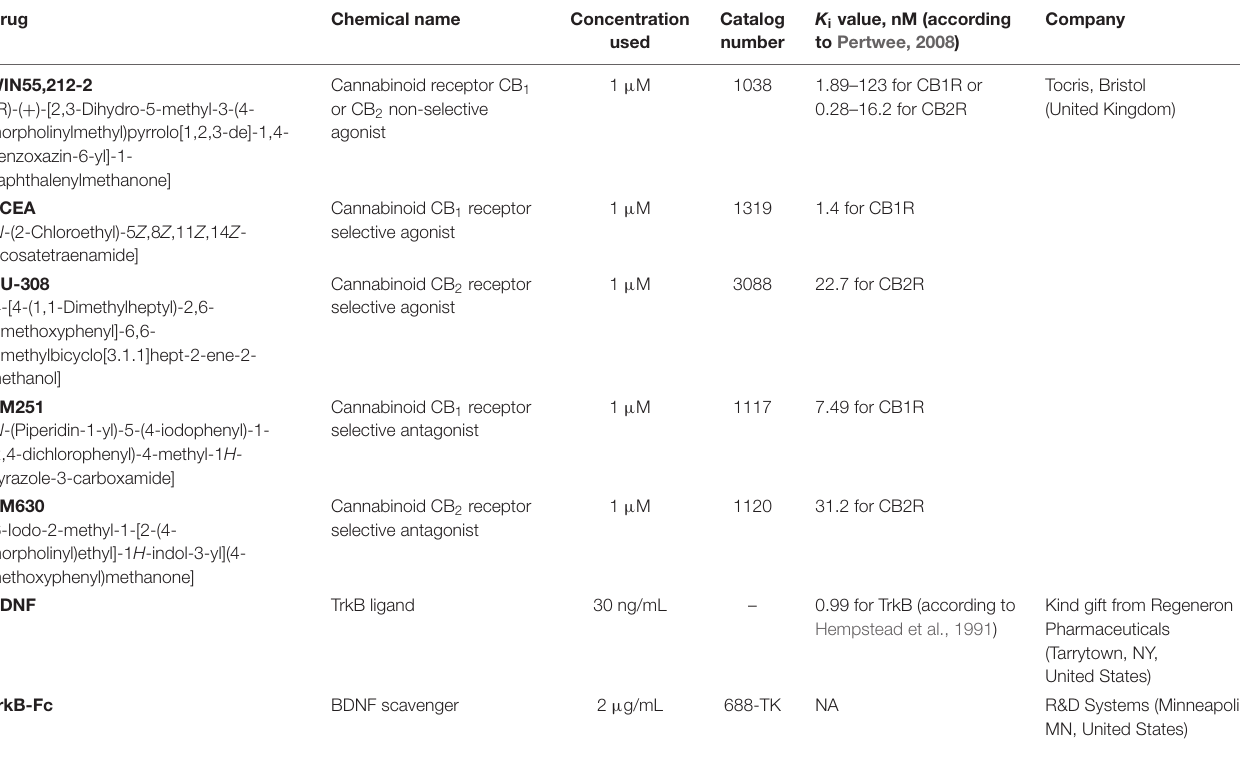
TABLE 1 | Pharmacological treatments